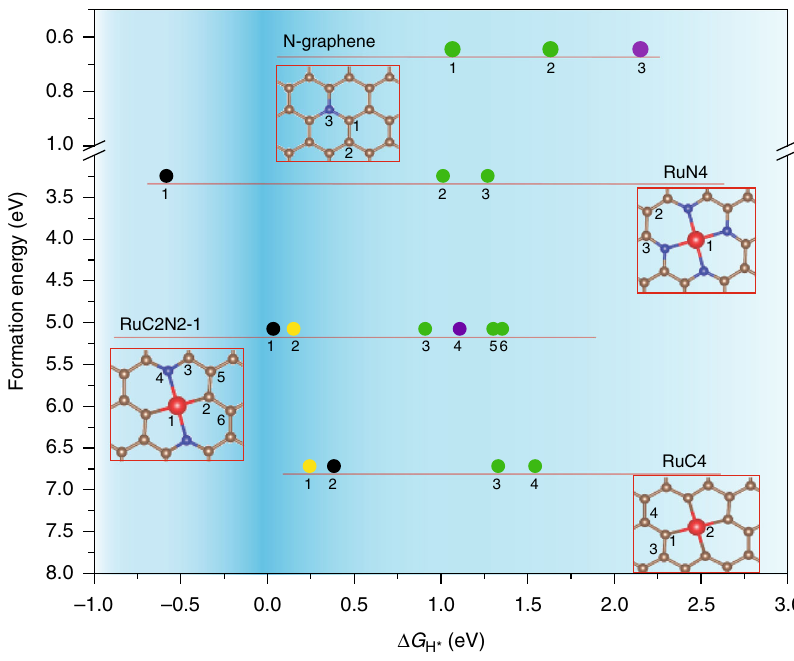
Fig. 5 Energy diagram of different RuC x N y structures from fi rst principles calculations. The x axis is reaction free energy of hydrogen binding, where the negative values indicate strong binding while positive values indicate weak binding. The dark blue range indicates the candidate active sites with the best activity. The y Axis is formation energy of each con fi guration, where a more positive value signi fi es a structure that is more dif fi cult to form. The colors denote candidate active sites: H binds to a ruthenium atom along the perpendicular direction to the plane (black), a carbon atom next to the ruthenium (yellow), a carbon atom next to nitrogen (green), or a carbon atom far away from ruthenium and nitrogen atoms (purple). The note records the data point from a certain structure, number records the possible active site. The version with complete RuC x N y con fi gurations can be found in